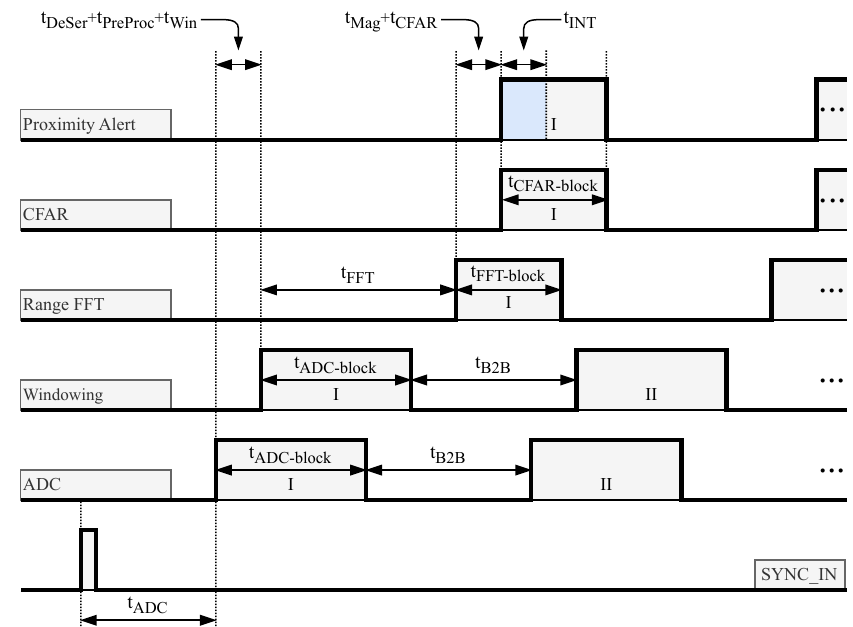
Figure 13. Illustration of the system latency when flushing is